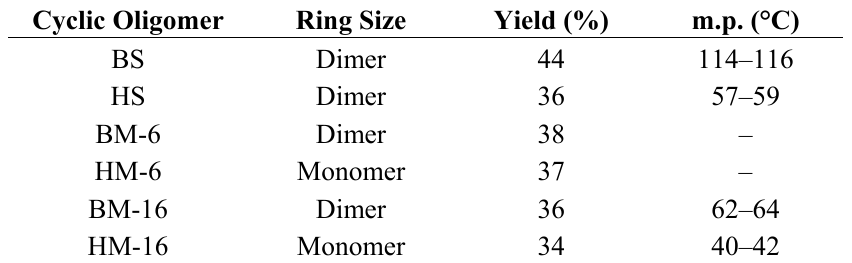
Table 1. Main components, yields and melting points of cyclic